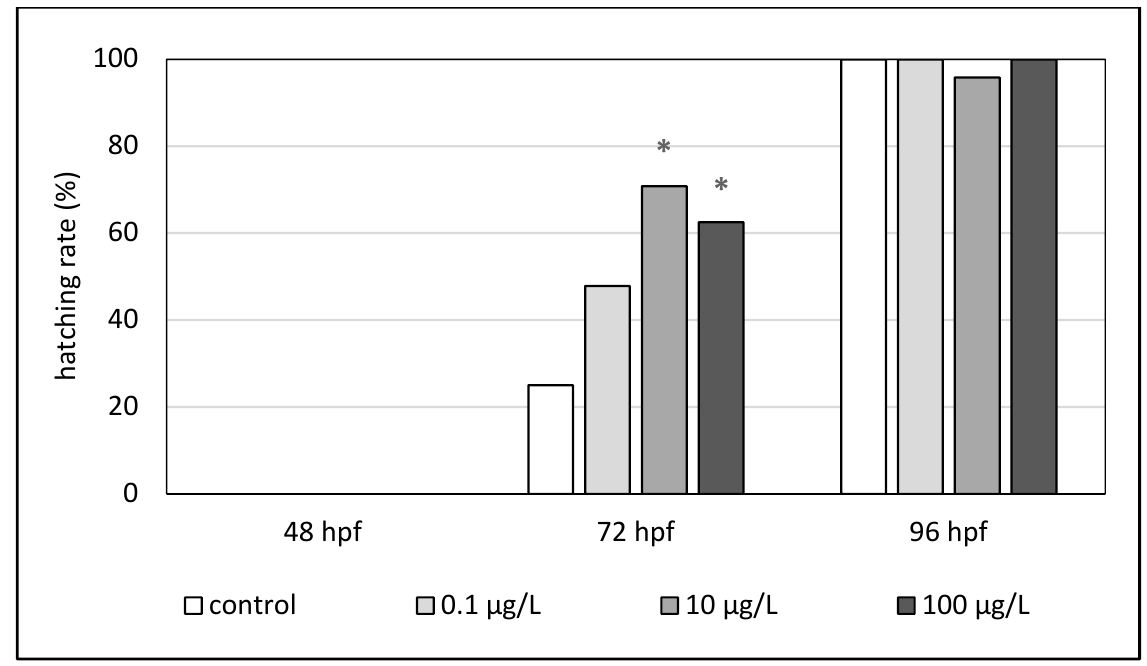
ference (* p < 0.05) between the control and experimental groups at the same time of exposure. experimental groups at the same time of exposure.